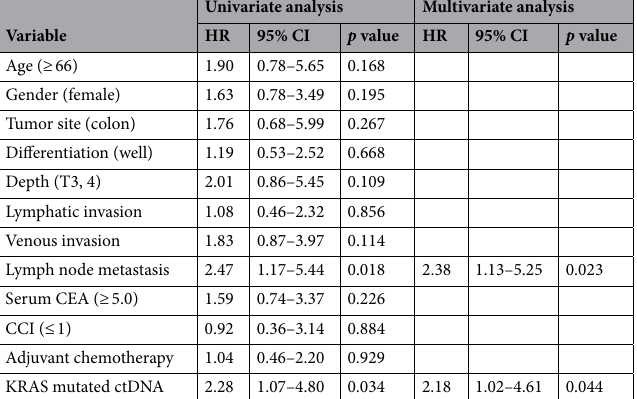
Table 5. Univariate and multivariate analysis of recurrence-free survival. HR hazard ratio; CI confidence interval; Well well differentiated adenocarcinoma; CEA carcinoembryonic antigen; CCI Charlson comorbidity